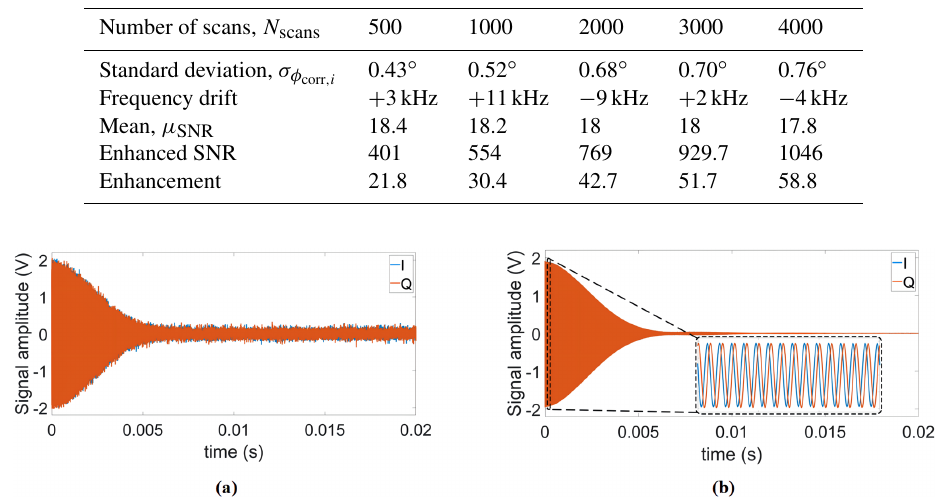
Table 2. Phase distribution and SNR of the recorded FID signals using the proposed DDS-based frequency generator for up to 4000 scans.